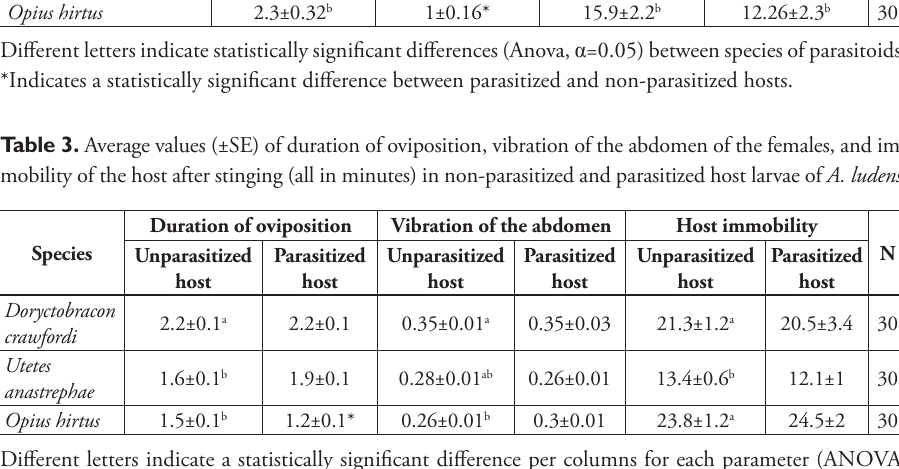
Different letters indicate a statistically significant difference per columns for each parameter (ANOVA, α =0.05). *Indicates a statistically significant difference between parasitized and non-parasitized hosts for each species per parameter.